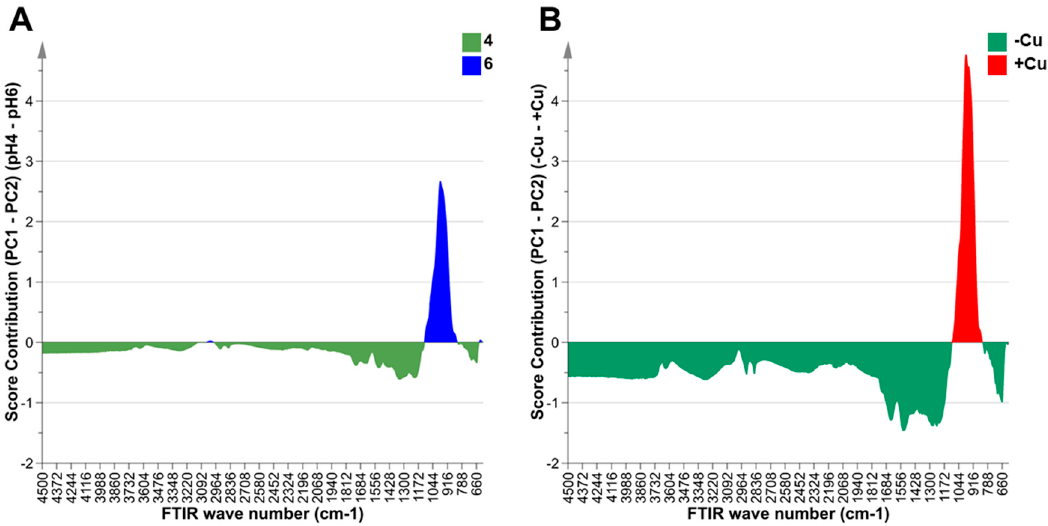
Figure 5. Score contribution plot values from PCA (PC1 and PC2 loading) from Fourier transform-infrared spectrometry (FT-IR) scans of Desmodesmus sp. AARLG074. FT-IR wavenumber score values are negative if they contribute towards PCA loadings associated with ( A ) growing in media at pH 4 (green) and positive for pH 6 (blue) and ( B ) negative if they contribute towards PCA loadings associated with no copper (green) and positive for copper supplemented media (red).